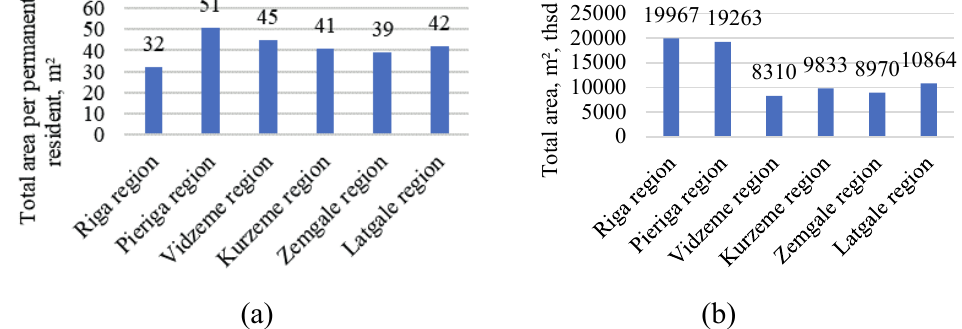
Fig. 10. Housing stock in statistical regions at the end of 2019, Latvia: a) Total area per permanent resident, m²; b) Total area, m², thsd (developed by the authors based on European Statistics Database Eurostat,